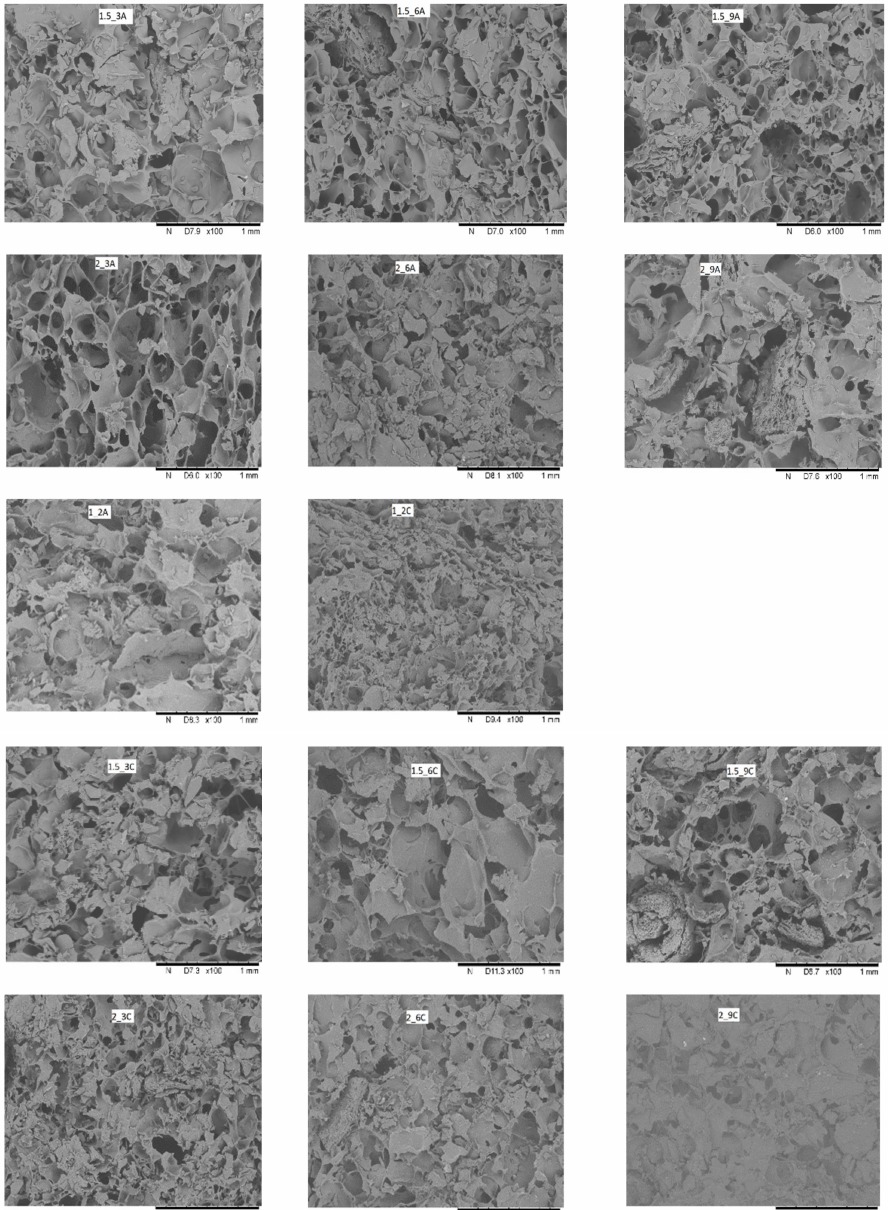
Figure 1. The effect of the amount of hydrocolloid and pomace addition on the structure of freeze- dried fruit bars with apple and chokeberry pomace at 100 × Magnification. Denotations in Table 1 include Index (A) next to the sample symbol—bars with the apple pomace, Index (C) next to the sample symbol—bars with the chokeberry